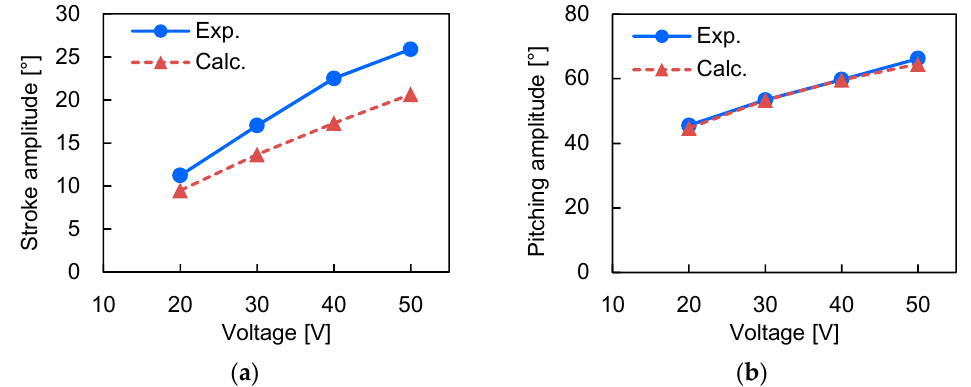
Figure 14. Relationship between applied voltage amplitude and ( a ) stroke amplitude and ( b ) pitching amplitude of large-type actuator. The frequencies of the input signal in the experiment and calculation were 105 and 109 Hz, respectively.